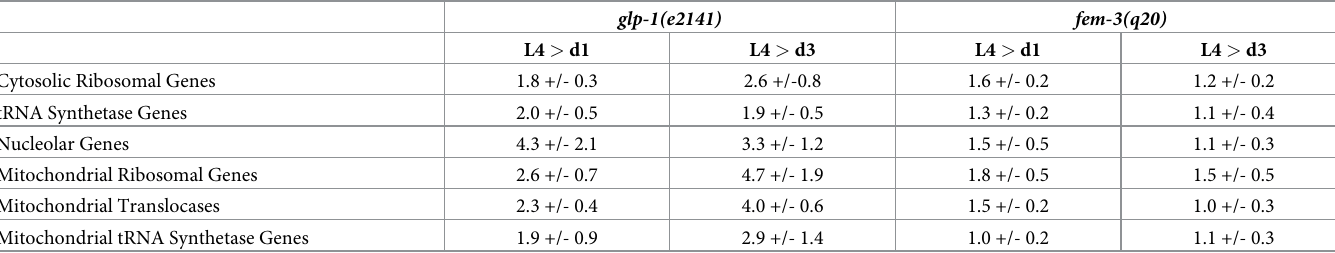
Table 1. Repression of Translation Genes in D1 and D3